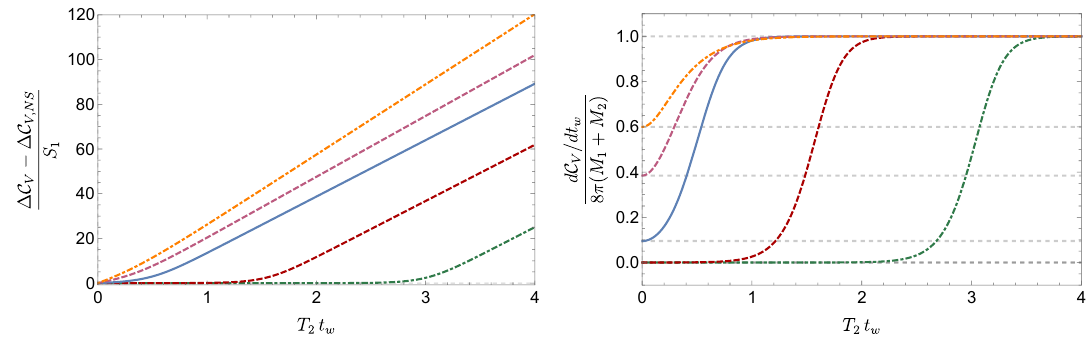
Figure 19. Complexity of Formation as a function of the shock time t w (left) and its derivative (right) for various energies of the shocks | w = 2 (orange, dot-dashed), w = 1 : 5 (pink, dashed), w = 1 : 1 (blue, solid), w = 1 + 10 (cid:0) 4 (red, dashed) and w = 1 + 10 (cid:0) 8 (green, dot-dashed). The slope of this plot is proportional to the di(cid:11)erence of the masses for small t w (not so early shocks) and to the sum of the masses for large t w (early shocks) and matches the predictions in eqs. (4.38){(4.39), indicated by dashed gray lines on the right plot.